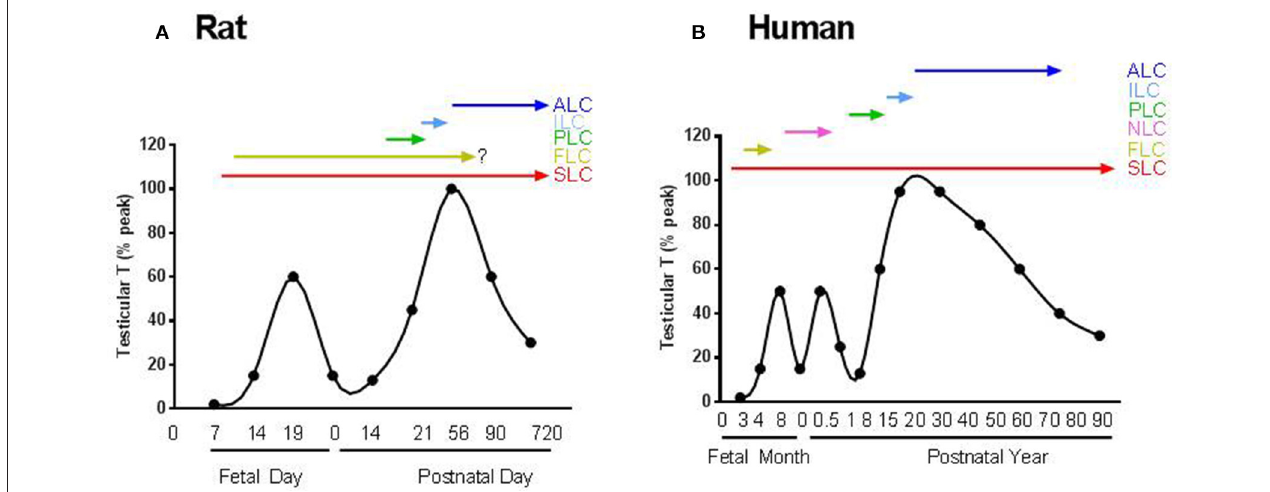
FIGURE 1 | The scheme for the androgen production and possible involvement of Leydig cells in the life span. (A) Rat; (B) Human. SLC, FLC, PLC, ILC, ALC, and NLC represent stem, fetal, progenitor, immature, adult and neonatal Leydig cells, respectively. There are two androgen peaks for rats and three androgen peaks for human.